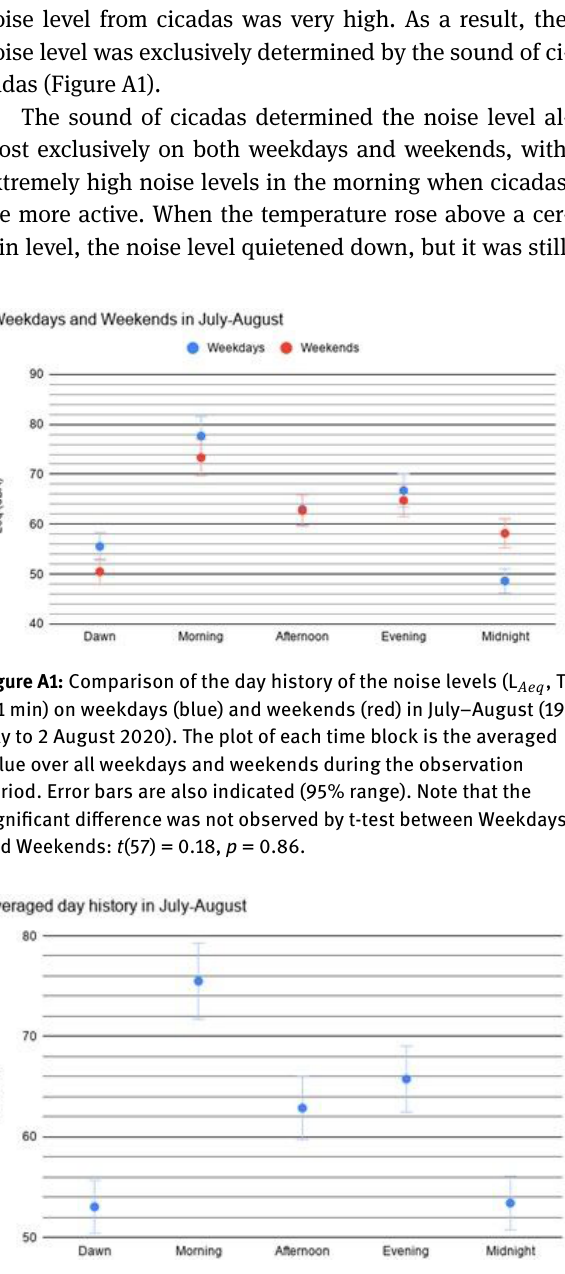
Figure A2: A comparison of the day history of the averaged noise levels (L , T = 1 min) over both weekdays and weekends in July– Aeq August. The plot of each time block is the averaged value over all weekdays and weekends during the observation period. Error bars are also indicated (95% range).